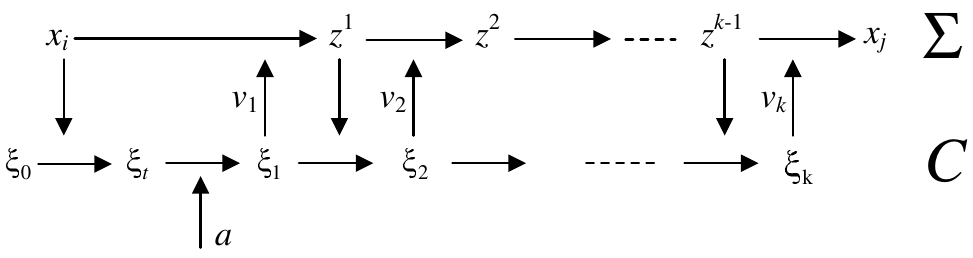
Figure 2. Interaction between C and Σ